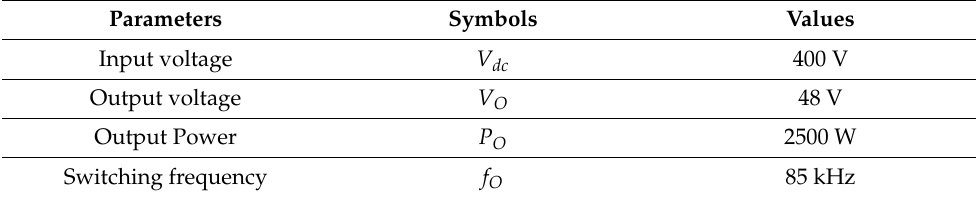
Table 8. Design specification of proposed IPT for LEV applications.